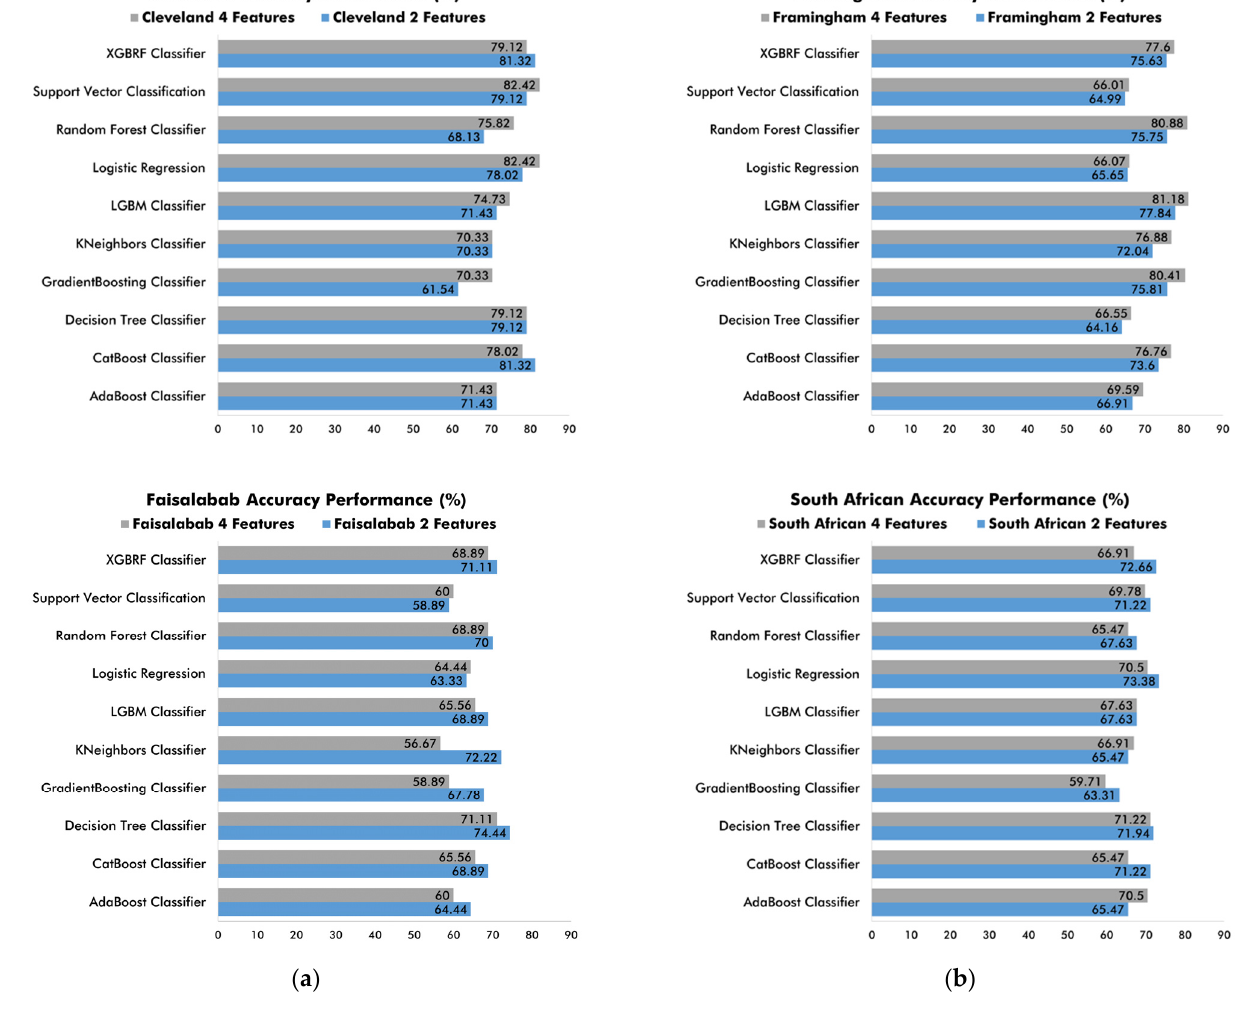
Figure 9. Comparison of ML classifier accuracy performance using train-test split on top-two and top-four attributes from ( a ) Medical diagnostic datasets; ( b ) Medical prediction datasets.